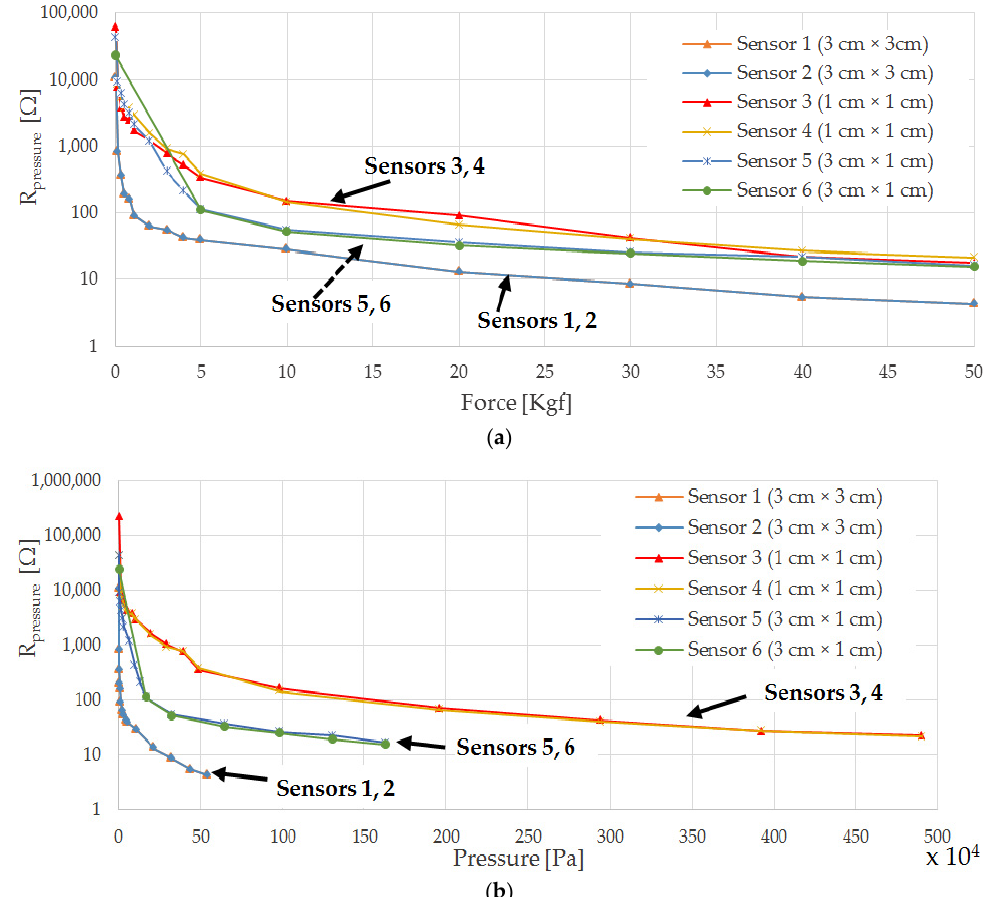
Figure 28. Summarizing graphs of characteristics (R pressure ) as a function of applied force (in Kgf) ( a ) and pressure (in Pa) ( b ) for previously tested sensors, all applied by epoxy glue on a felt base.